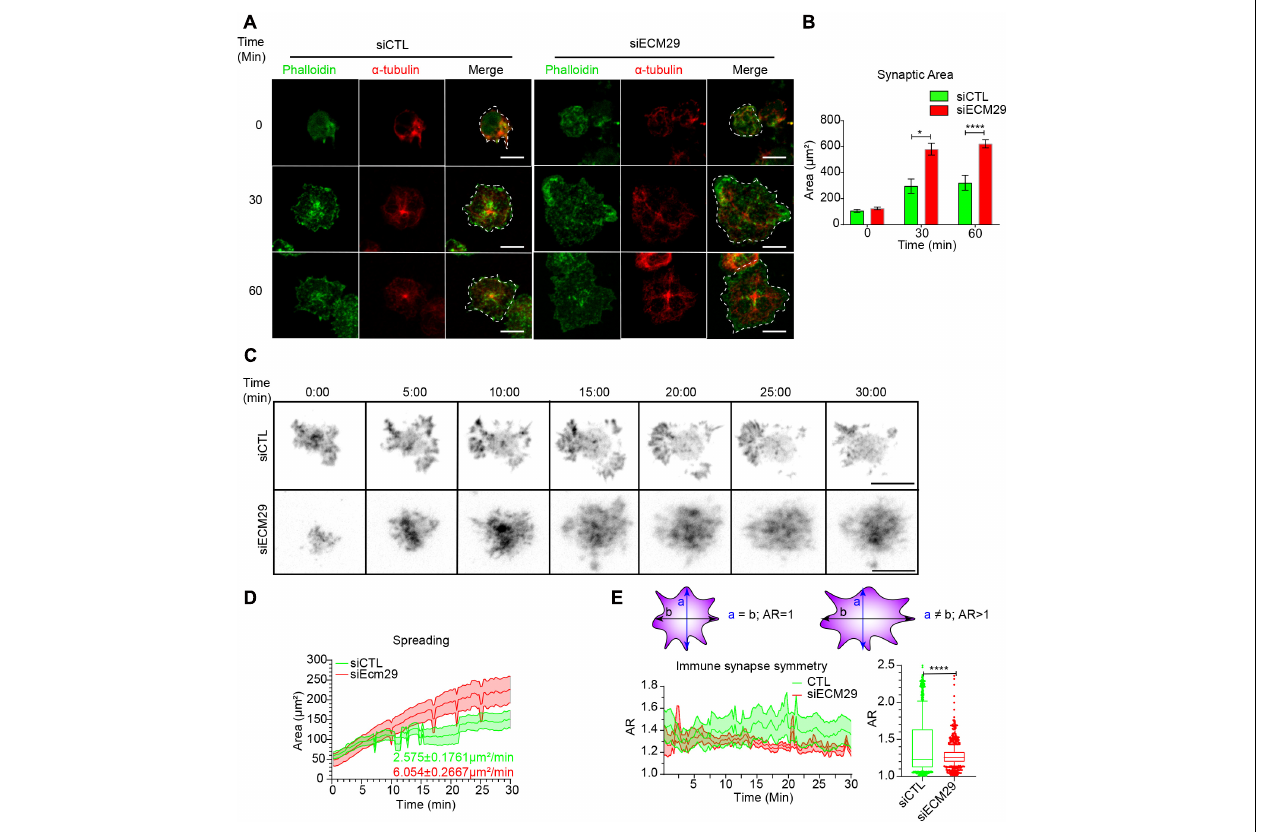
FIGURE 3 | Ecm29 silencing enhances B cell spreading responses: (A) Representative confocal images of control (siCTL) and Ecm29-silenced (siECM29) B cells activated for different time points (0, 30, and 60 min), stained with phalloidin (green) and α -Tubulin (red) are shown. (B) Quantification of the spreading area in (A) . N = 3. Cells > 40. (C) Representative Time-lapse images acquired by TIRFM of control and Ecm29-silenced B cells expressing LifeAct-mCherry (grayscale). (D,E) Quantification of the spreading area and aspect ratio (AR) and a schematic representation of AR values in (C) , respectively. The mean spreading velocity and mean AR are shown. N = 10. * p < 0.05. **** p < 0.0001. Kruskal–Wallis test with Dunn’s test, and Mann-Whitney test was performed for all statistical analyses were performed. Mean with SEM bars (B) , lines (D,E) , and boxes and whiskers with 10% percentile (E) are shown. Scale bar = 10 µ